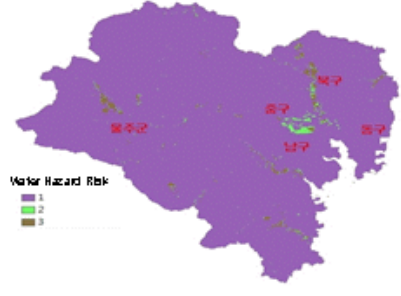
Figure 4. River and Inland Flood Hazard 3 Grade Reclassification Map